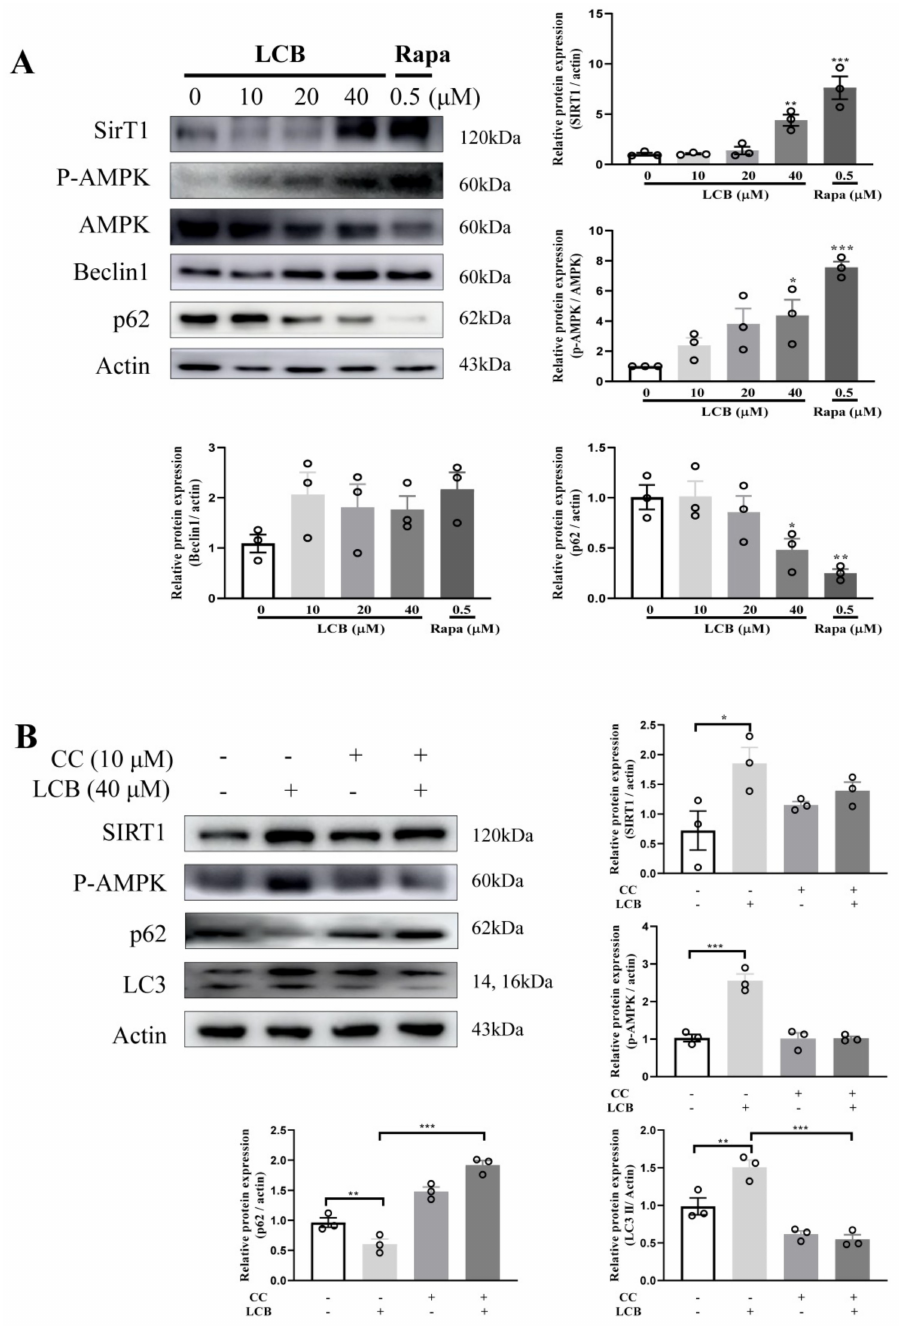
Figure 7. LCB activates autophagy via the SIRT1/AMPK pathway. ( A ) PC-12 cells were treated with LCB under the indicated concentrations for 24 h. After treatment, cell lysates were harvested for the analysis of SIRT1, P–AMPK, Beclin–1, and p62 by Western blot. ( B ) PC-12 cells were treated with LCB or cotreated with LCB and CC under the indicated concentrations for 24 h. After treatment, cell lysates were harvested for the analysis of SIRT1, P–AMPK, and p62 and LC3 by Western blot. Bar chart indicating the normalization of the interest proteins to β –actin. * p < 0.05, ** p < 0.01, *** p < 0.001. The original uncropped images of Western blotting are shown in Supplementary Figure